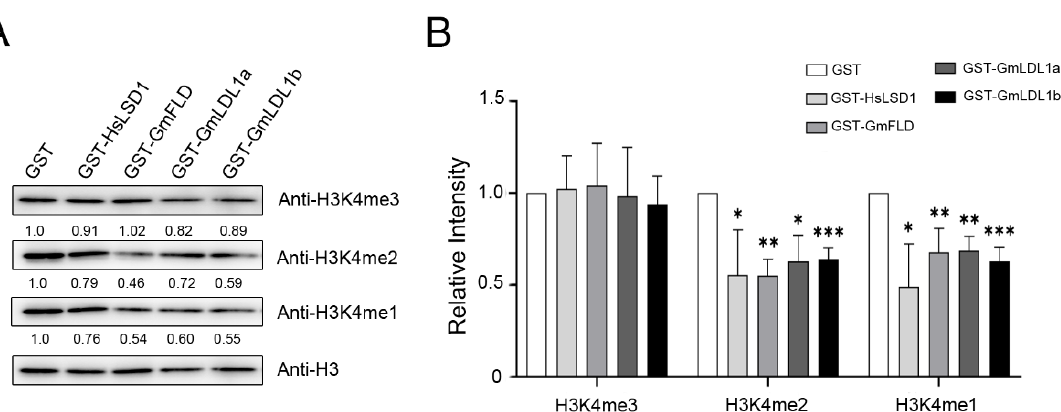
Figure 6. GST-GmLDLs exhibit H3K4me1/2 demethylase activity in vitro. ( A ) E. coli -expressed and affinity-purified proteins were incubated with calf thymus histone, and the H3K4 methylation status was determined using methylation-specific antibodies. GST-HsLSD1 was used as a positive control and anti-H3 was used as a loading control. ( B ) Quantification analysis of ( A ) by ImageJ 1.8.0. The mean values are from three independent biological replicates. Statistical analyses were performed by Student’s t -test (* p < 0.05, ** p < 0.01 and *** p < 0.001).